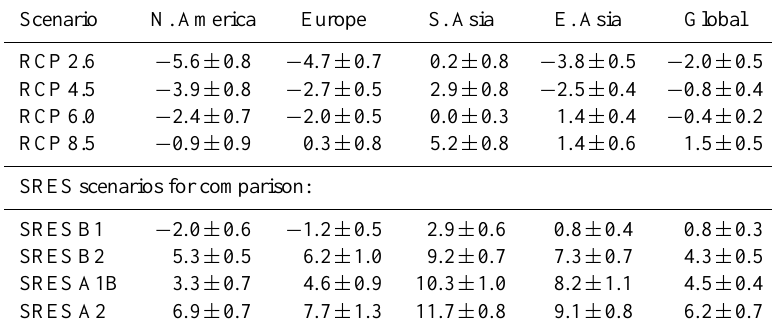
Fig. 8. Model ensemble annual regional mean surface O 3 changes over the four HTAP regions from the parameterization following (a) the different RCP precursor emission pathways and (b) the SRES scenarios. The y-axis spans an O 3 change of 14ppb in each case to allow direct comparison of the magnitude of O 3 changes. Table 3. Annual regional mean surface O 3 changes (in ppb) by 2050 along the RCP and SRES scenarios showing model ensemble mean and one standard